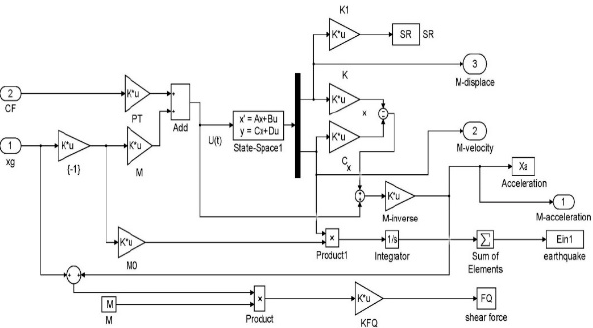
Figure 8. Simulation model of the main structure of the Small Wild Goose Pagoda.